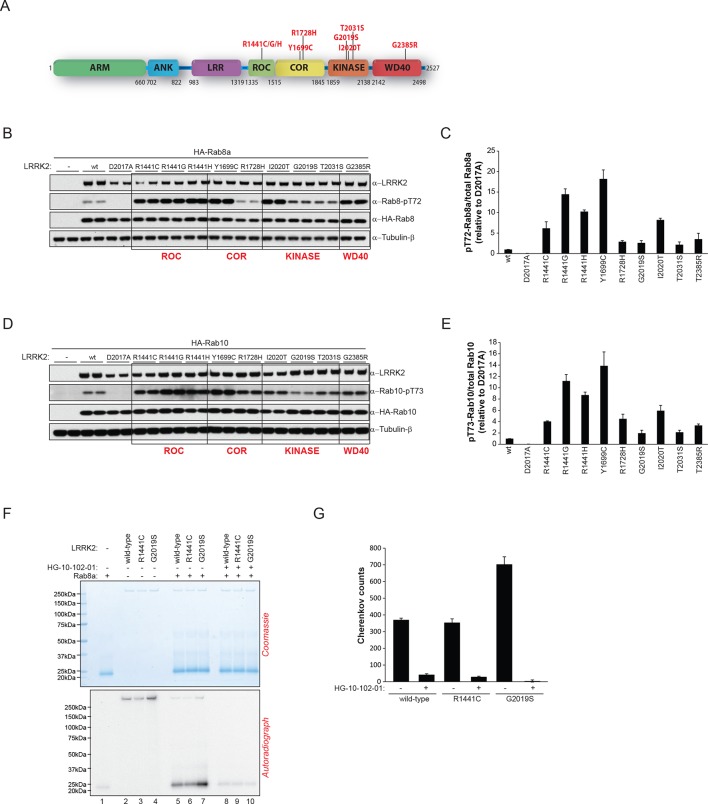
LRRK2 pathogenic variants increase phosphorylation of Rab GTPases.(A) Scheme of LRRK2 and common PD-associated amino acid substitutions (in red). (B) Different LRRK2 versions were co-expressed with Rab8a in HEK293 cells, lysates subjected to immunoblot analysis and (C) indicated signals quantified. (D) and (E) Same as (B) but HA-Rab10 was used. (F) In vitro phosphorylation of recombinant Rab8a (4 µM) by indicated LRRK2 variants (100 ng) and (G) quantification of the signals. HG-10-102-01= 2 µM. Error bars indicate mean ± SEM of replicates (n=3). PD, Parkinson's disease; SEM, standard error of the mean.